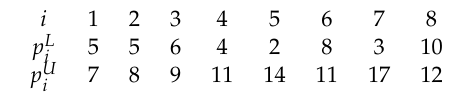
Table 1. Input data for the instance of the problem 1 | p L